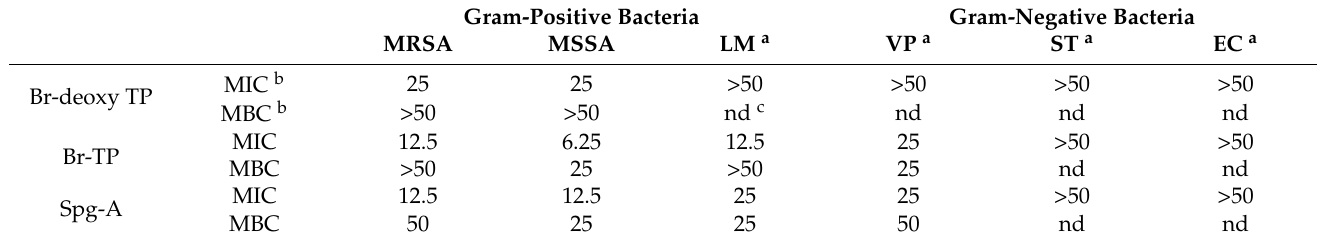
Table 1. MIC and MBC of bis-indoles against Gram-negative and Gram-positive bacteria. Gram-Positive